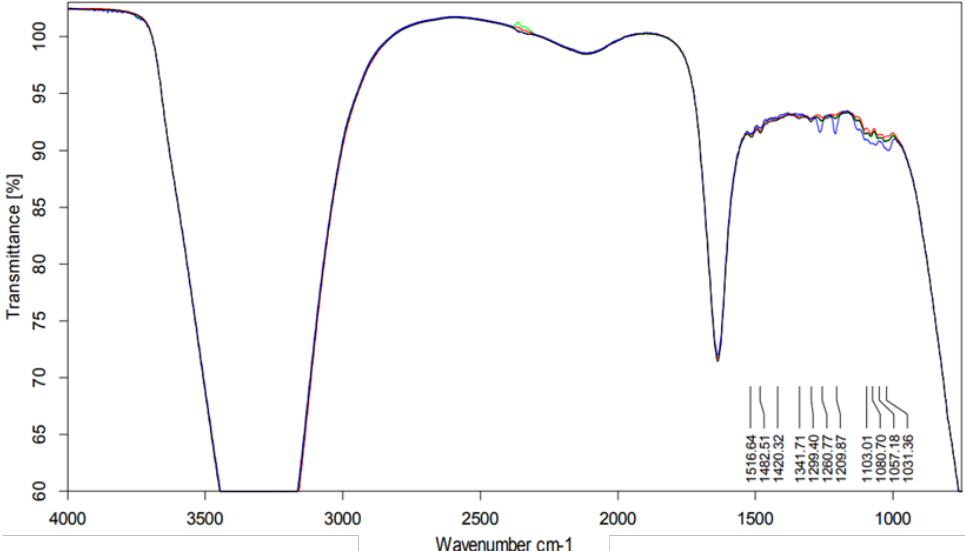
Figure 7. Overlap of the IR spectra referring to Vidaza ® (25 mg/mL) at t 0 (blue line), stored in the original container for up to 22 h (red line), in a polypropylene syringe (black line), and in a polypropylene syringe placed between two refrigerant gel packs (green line) for up to 96 h. Peak maxima for water were observed at 3450 cm −1 (2.898 μ m), 3615 cm −1 (2.766 μ m), and 1640 cm −1 (6.097 μ m).